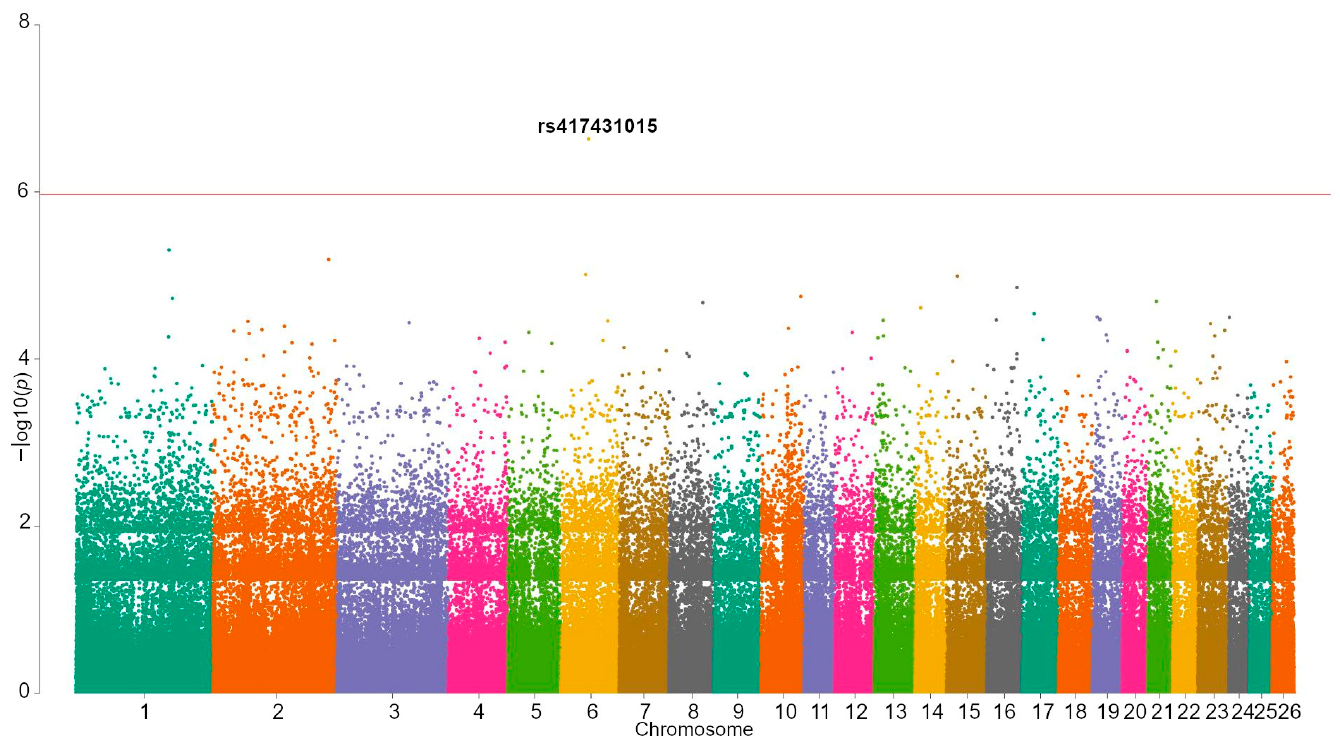
Figure 1. Manhattan plot of the viability GWAS. The solid red line represent a significance threshold of 1.08 × 10 − 6